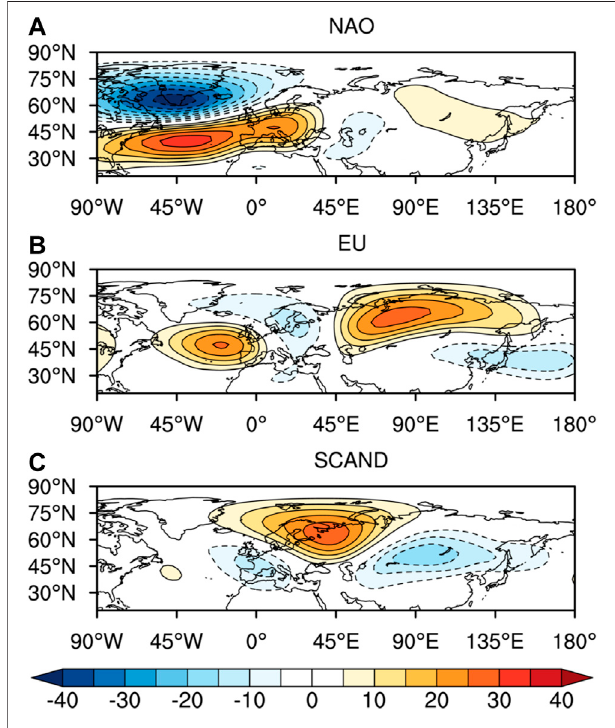
FIGURE 2 | The positive phase of (A) the NAO (North Atlantic Oscillation), (B) the EU (Eurasian) pattern and (C) the SCAND (Scandinavian) pattern obtained from the REOF analysis performed to the DJF-mean 700- hPa geopotential height anomalies from 1979/80 to 2019/20 [following the de fi nition in Barnston and Livezey